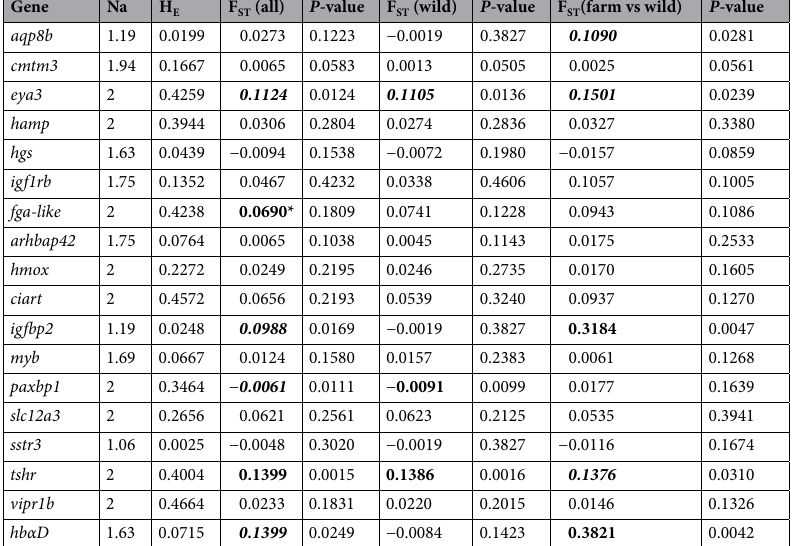
Table 3. Genetic diversity and differentiation of non-synonymous allelic variants in wild and farm turbot ( Scophthalmus maximus ) populations. In bold are shown outlier loci due to divergent (high F ST ) or stabilizing (low F ST ) selection with ARLEQUIN at P < 0.01 (consistent) or P < 0.05 (italics, suggestive) with respect to neutrality, and with BAYESCAN (p < 0.05, highlighted with